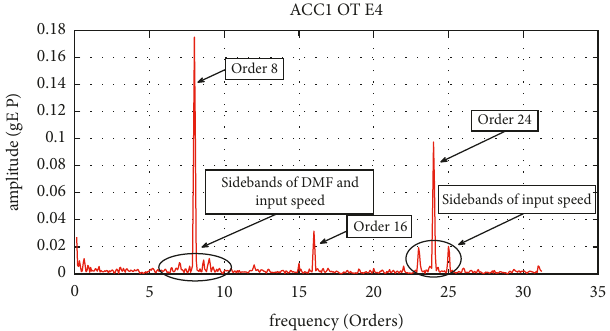
Figure 16: Cyclostationary without damage.